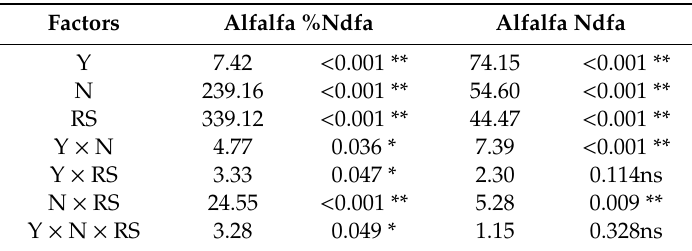
Table A3. Results of repeated measures ANOVA about e ff ects of year (Y), nitrogen levels (N), and root separation method (RS) on %Ndfa and Ndfa of alfalfa.